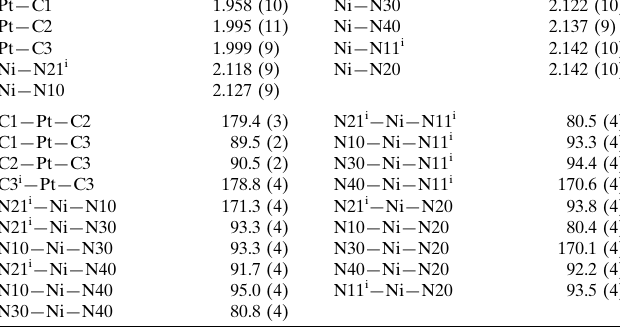
Selected geometric parameters (A˚ , (cid:4) ).